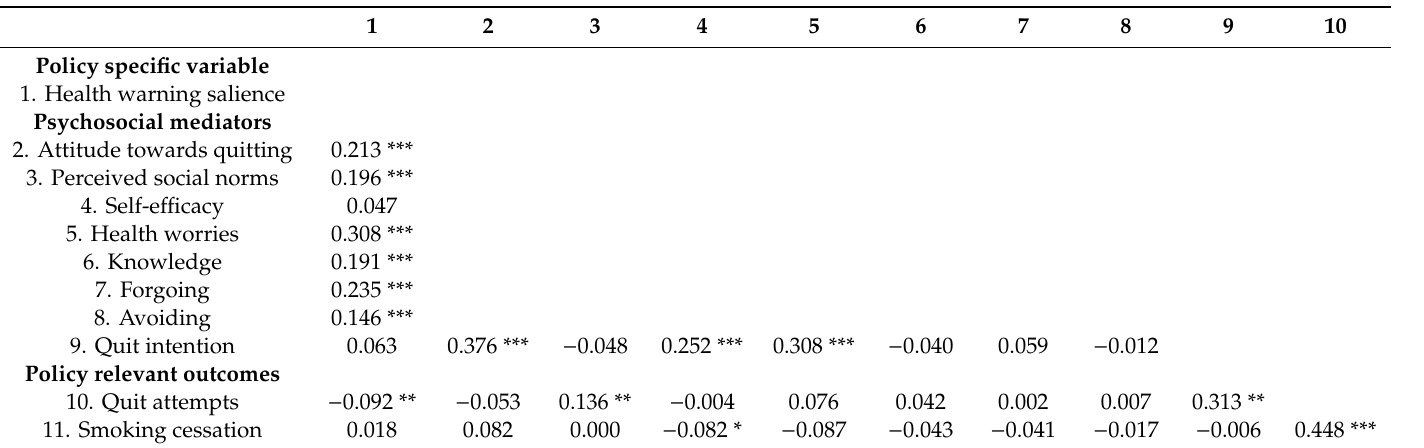
Table 5. Standardized regression coe ffi cients ( β ) of the structural equation model for the analysis on complete cases, weighted by age and gender a